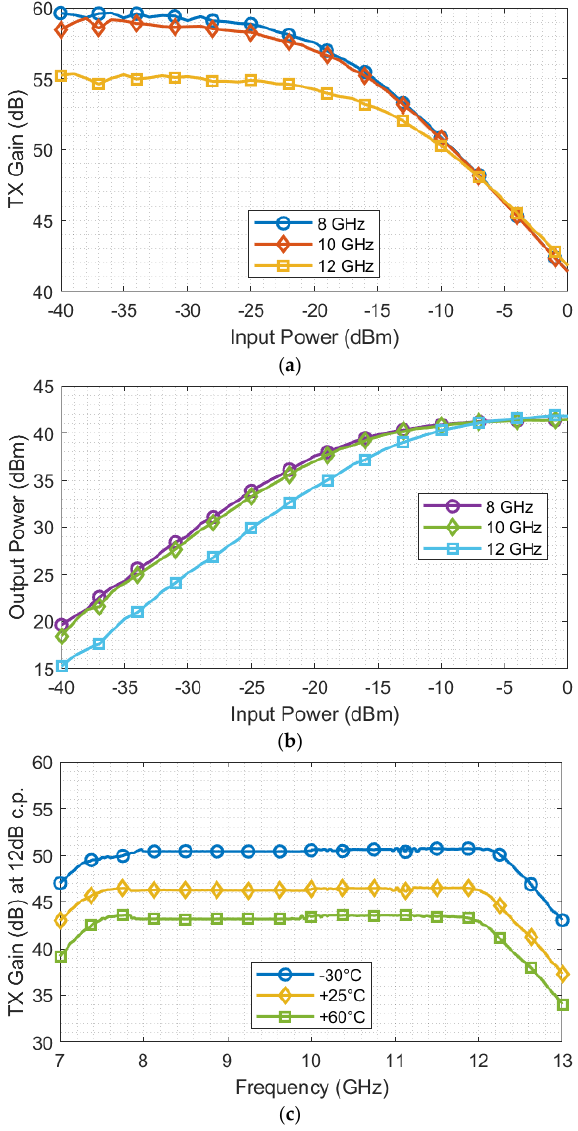
Figure 13. ( a ) TX gain and ( b ) output power P out as function of the input power P in . ( c ) TX gain at 12 dB compression point (P in = − 3 dBm) at three temperatures. The receive mode is also experimentally characterized by measuring the input and output return loss and the RX gain. The RX chain works in the linear region due to the very low power expected from the antenna. The S 11 (from the antenna port) and S 22 (from the RXout Port) are shown in Figure 14a, whereas the S 21 (RX gain) is reported in Figure 14b. The noise figure (NF) is the last parameter that requires a careful evaluation, since it greatly impacts the sensitivity of the overall RX chain and thus the level of the minimum